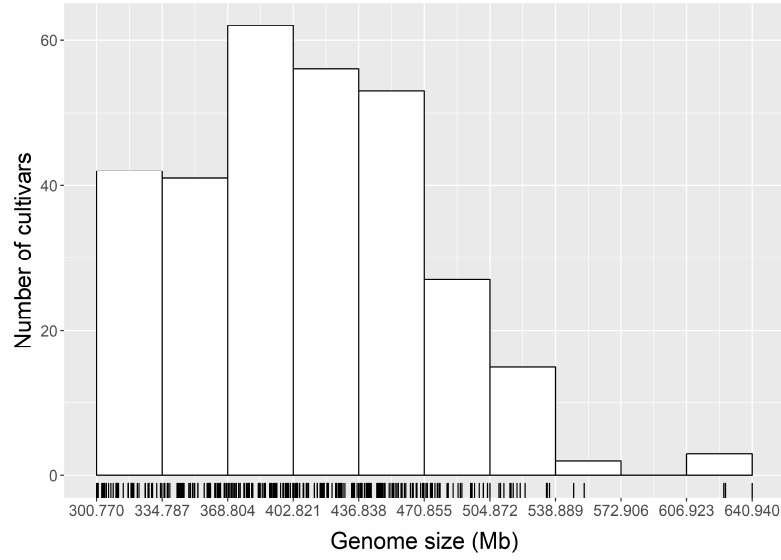
Figure 2. Histogram distribution of genome sizes of 301 cultivars of Chinese jujube.